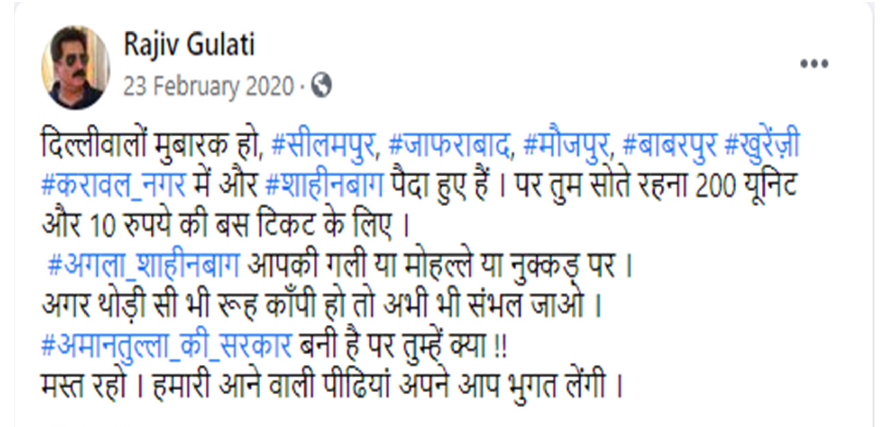
Figure 1. Tweet on 23 February warning people in Delhi that while they lay asleep, Shaheen Bagh type areas are being set up near their allies and neighborhood. “Our future generations will suffer from this”.